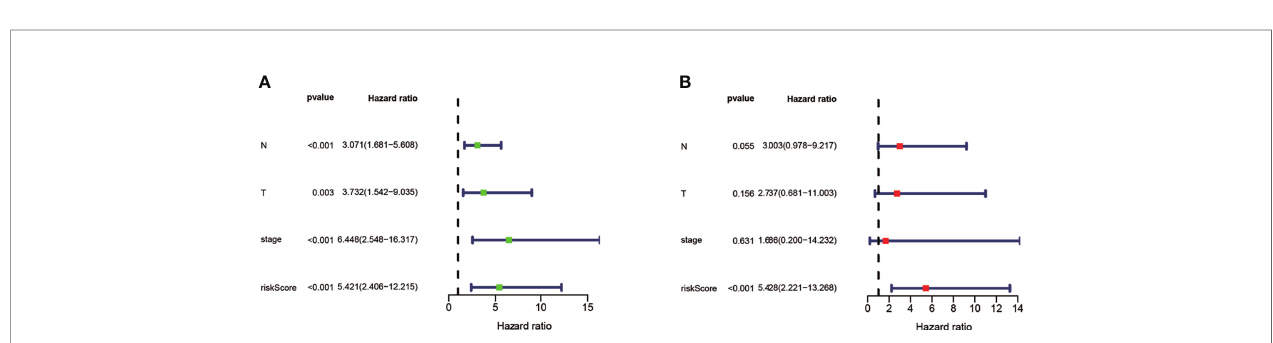
FIGURE 5 | Correlation between the risk score and overall survival in the test set. (A) The risk score strati fi ed the TNBC patients into high-risk groups ( “ High ” red line) and low-risk groups ( “ Low ” green line). (B) Kaplan – Meier survival curves to show survival probability comparing the high-risk groups with low-risk group. (C) Survival time and survival status of patients in TNBC comparing high-risk group with low-risk group. Green plots for alive, red plots for dead. (D) Heatmap showing expression of the six genes screened from ARGs in TNBC. Blue color represents high group, while pink color represents low group. The color scale represented the expression levels normalized by z-score. (E) Time-dependent ROC curves for survival prediction by the risk score.